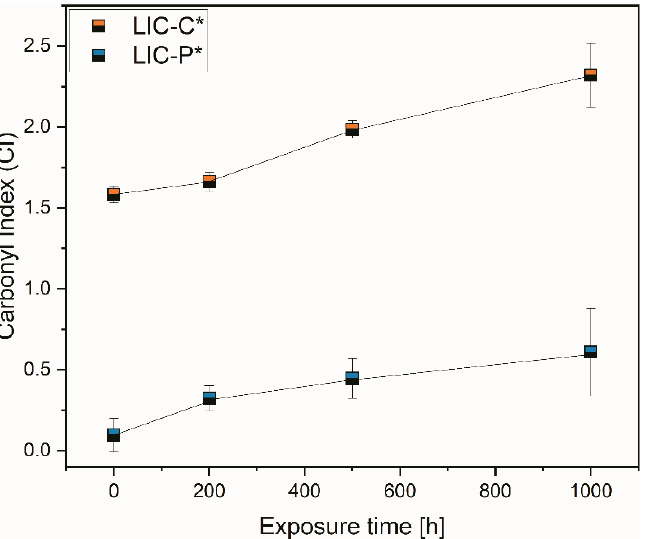
Figure 15. Comparison of carbonyl indices (CI) of LIC-C* and LIC-P* coatings calculated using the specified area under band (SAUB) methodology.